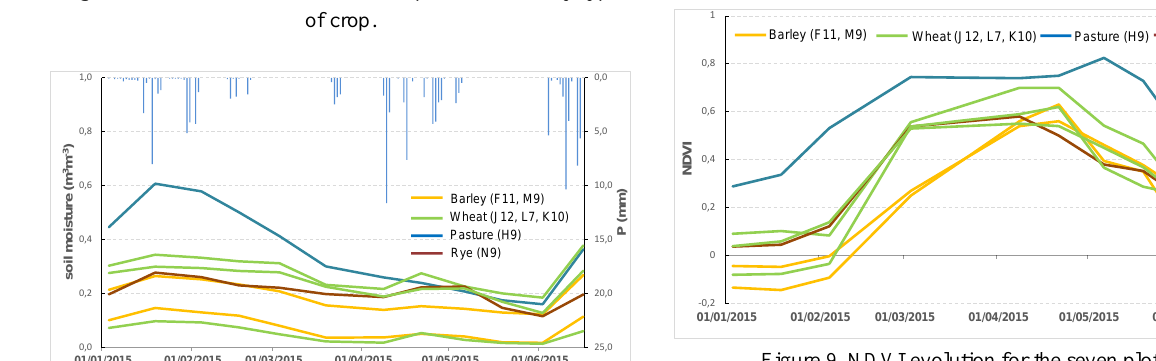
Figure 9. NDVI evolution for the seven plots